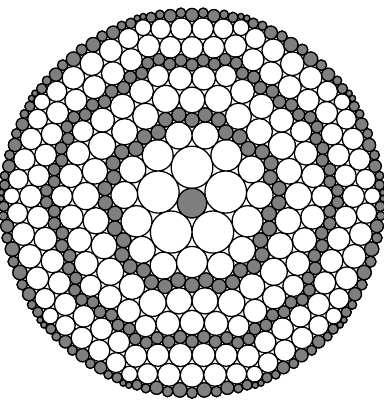
Figure 5.2. A portion of the layered packing generated by the sequence { 5,7,7,5,7,7, ... } . The circles of degree 5 are